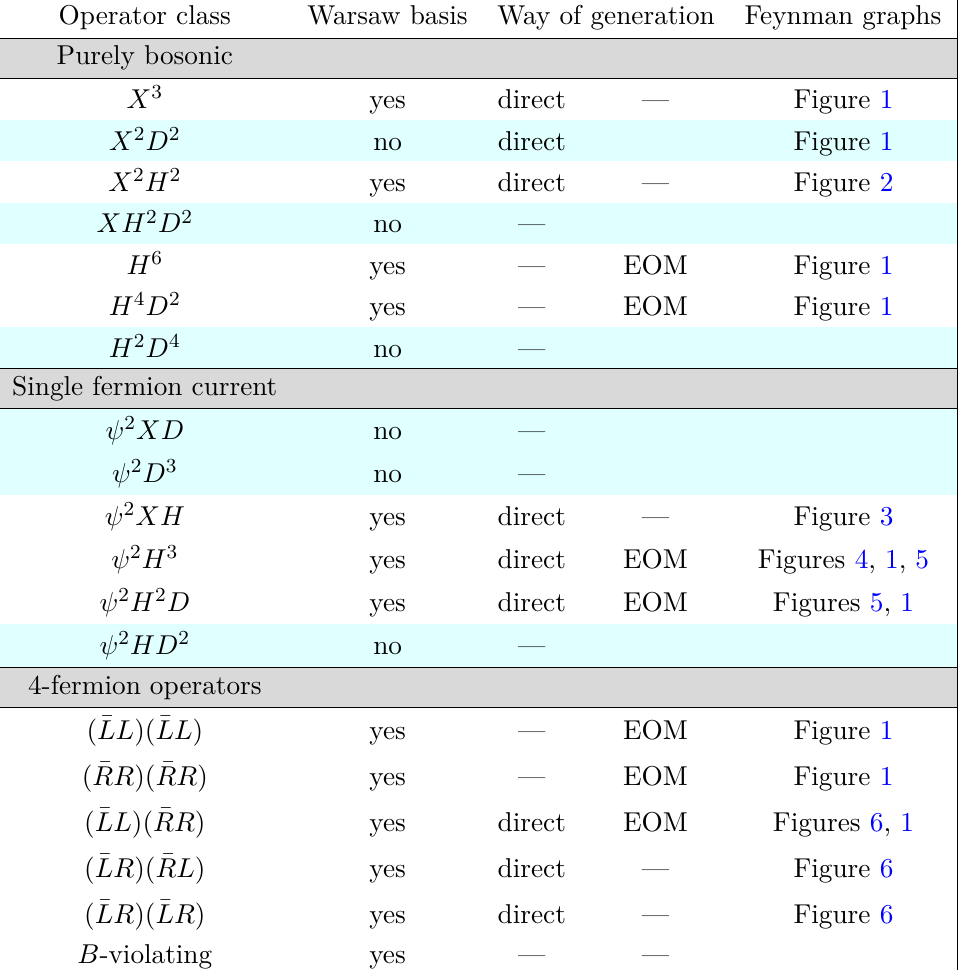
Table 1 . Summary of the different classes of dimension-6 operators in the extended SMEFT basis. X represents a field-strength tensor (normal or dual), H a Higgs field, ψ a chiral fermion, and D a covariant derivative. Operators contained in the Warsaw basis are shown on white background, while redundant operators are highlighted in blue. The third and fourth columns show which operators are generated by one-loop ALP exchange, either directly or via the EOMs. The last column refers to the figures showing the relevant Feynman diagrams. When more than one figure is listed, the first number refers to the figure showing the direct